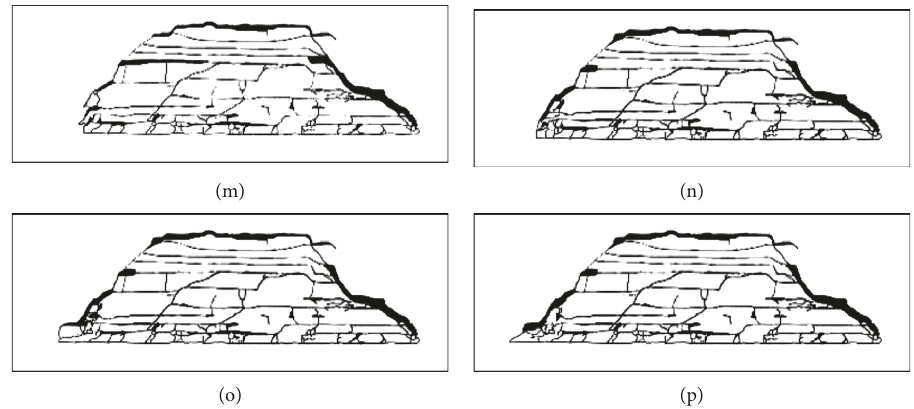
Figure 3: Fracture network evolution (mining face 5-1). Mining length: (a) 300mm; (b) 450mm; (c) 600mm; (d) 800mm; (e) 1000mm; (f) 1100mm; (g) 1200mm; (h) 1250mm; (i) 1350mm; (j) 1500mm; (k) 1700mm; (l) 1800mm; (m) 1900mm; (n) 1950mm; (o) 2050mm; (p) 2100mm.